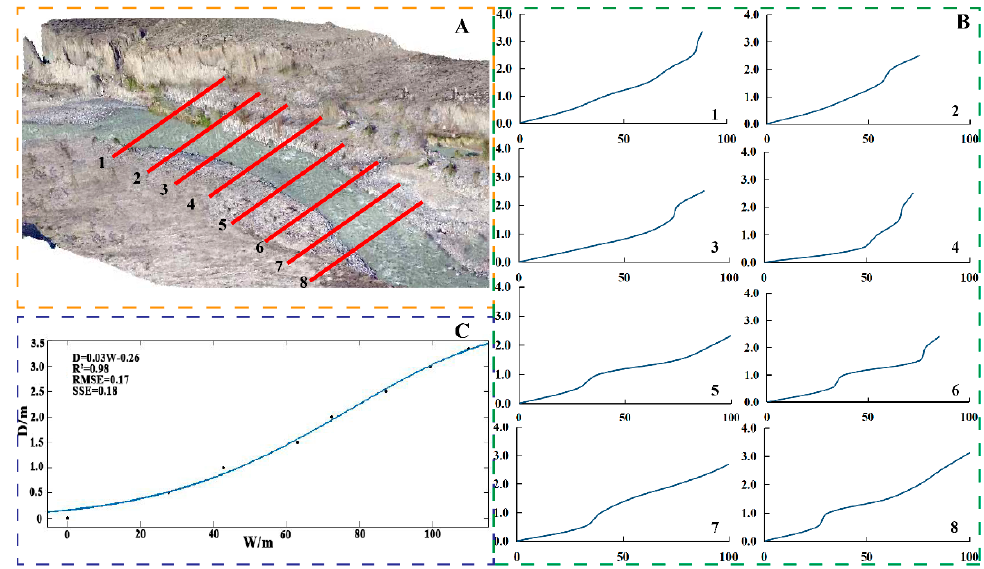
Figure 2. Flow diagram fitting relationship between average river width and water depth. ( A ): Divide the river section; ( B ): Establish the water surface width-depth relationship curve of the divided section; ( C ):Generalize the water surface width-water depth curve of the river section.